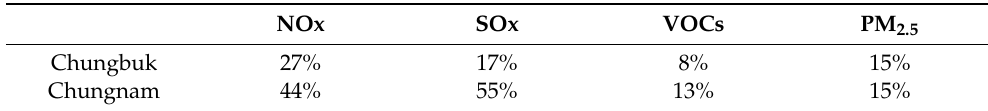
Table 6. Emission reduction rates of Chungcheong for S2.